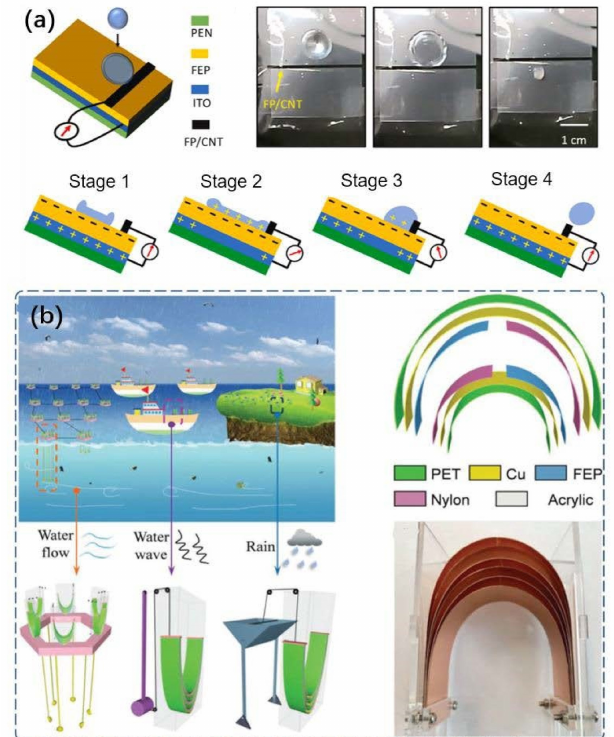
Figure 12. ( a ) A droplet-based electricity generator (DEG) and self-powered electronic skin